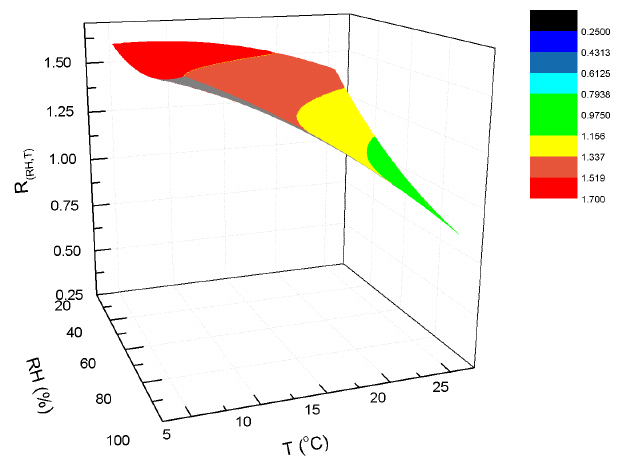
Figure 4. Simulation of experimental reaction rate coefficient, ambient relative humidity (RH), and temperature ( T ) for HCHO ( m/z 31).